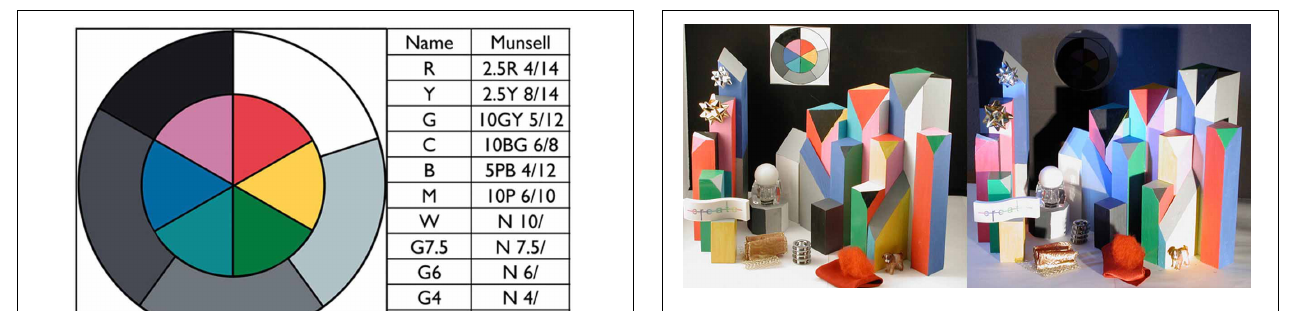
FIGURE 3 | Photographs of the Low-Dynamic-Range (LDR) part of the scene on left, and High-Dynamic-Range (HDR) on right. a black background. We directed eight tungsten-halide spotlights on the sides and top of the illumination cube. The combination of multiple lamps with identical emission spectra,